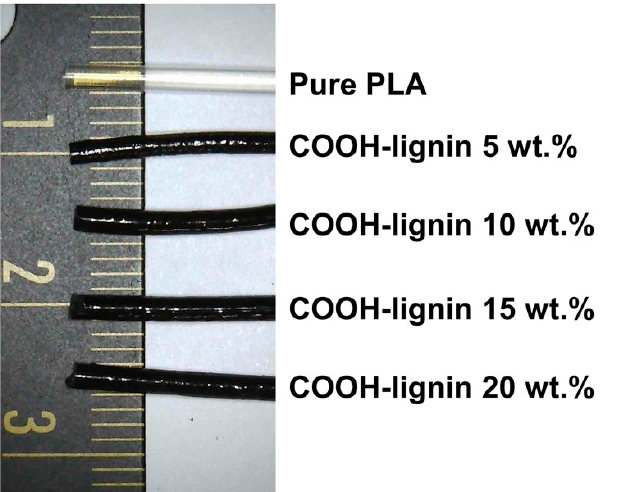
Figure 5. Photographs of PLA and COOH-lignin-reinforced PLA biocomposite filaments.